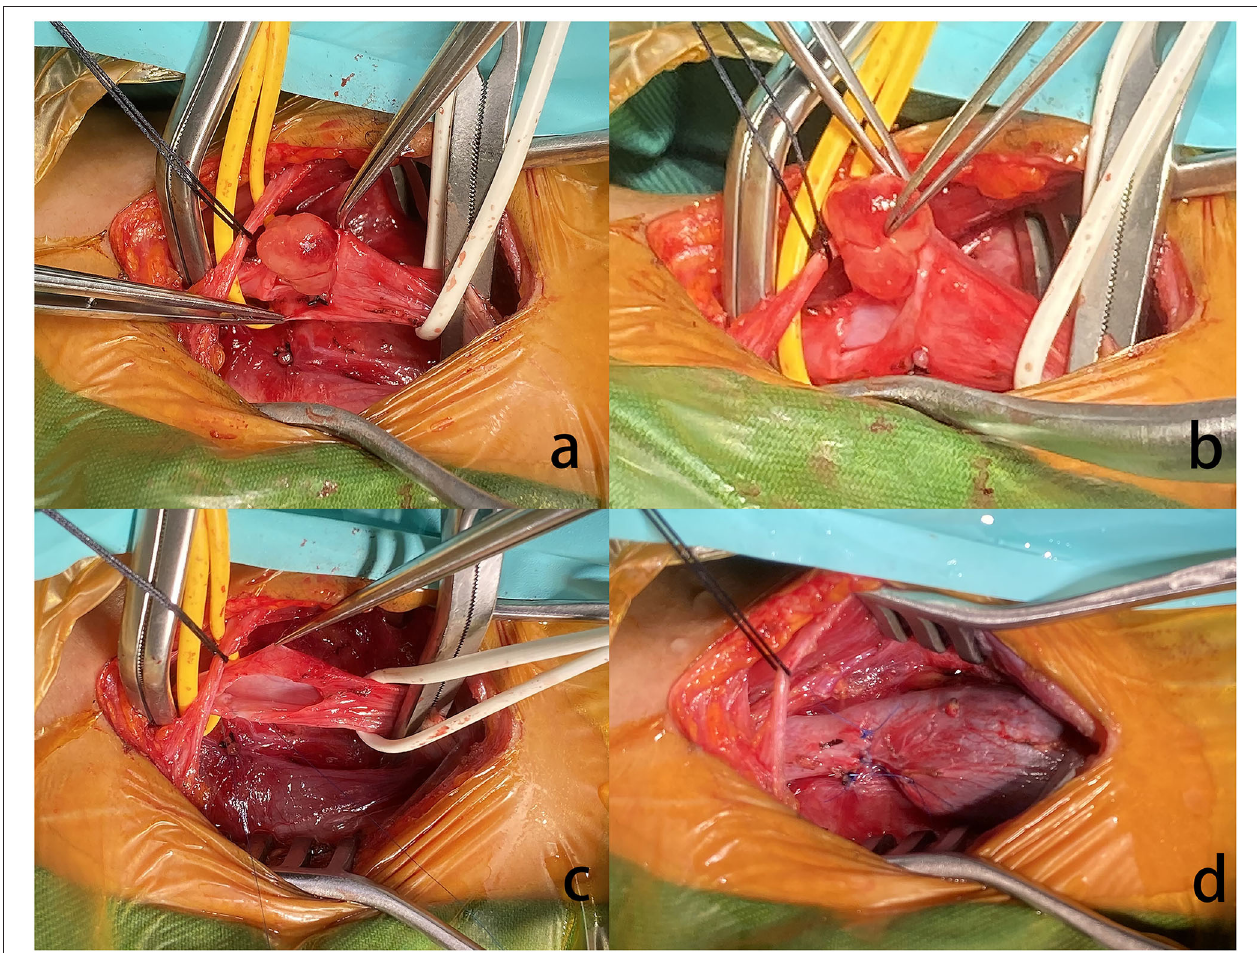
FIGURE 2 | (a) The nodule arose from the RJV. (b) Grossly, the mass was pink hyaline, oval, and well-demarcated, measuring ∼ 5mm in diameter. (c) Extravascular tissues were not affected. (d) Due to the proximal of RJV compensatory dilation, local stenosis was observed in the RJV after reconstruction.